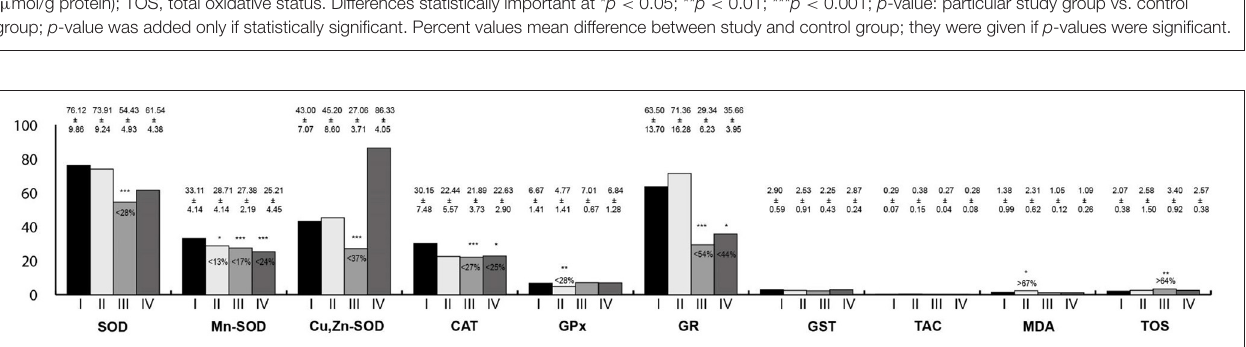
FIGURE 6 | Oxidative stress parameters in the large intestine homogenates. I, control group; II, group exposed to LF-EMFs; III, group exposed to RF-RMF; IV, group exposed simultaneously to LF-EMFs and RF-EMFs; SOD, superoxide dismutase (NU/mg protein); Mn-SOD, manganese-dependent superoxide dismutase (NU/mg protein); Cu,Zn-SOD, copper- and zinc-dependent superoxide dismutase (NU/mg protein); CAT, catalase (IU/g protein); GPx, glutathione peroxidase (IU/g protein); GR, glutathione reductase (IU/g protein); GST, glutathione S-transferase (IU/g protein); TAC, total antioxidant capacity (mmol/g protein); MDA, malondialdehyde ( µ mol/g protein); TOS, total oxidative status. Differences statistically important at * p < 0.05; ** p < 0.01; *** p < 0.001; p -value: particular study group vs. control group; p -value was added only if statistically significant. Percent values mean difference between study and control group; they were given if p -values were